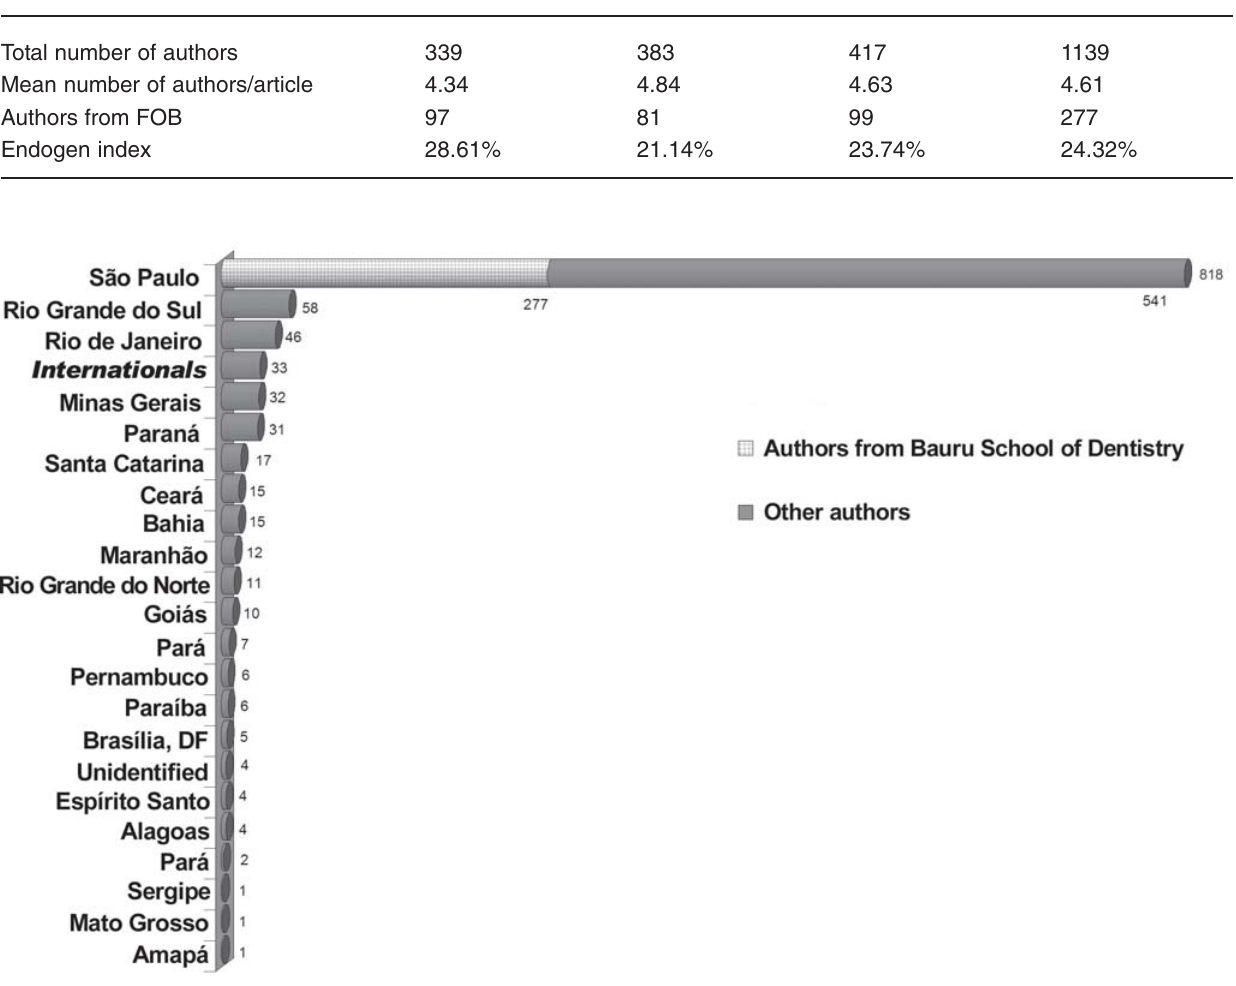
FIGURE 1- Geographic distribution of the authors who had articles published in the JAOS between 2005 and 2007 (Brazilian States and other